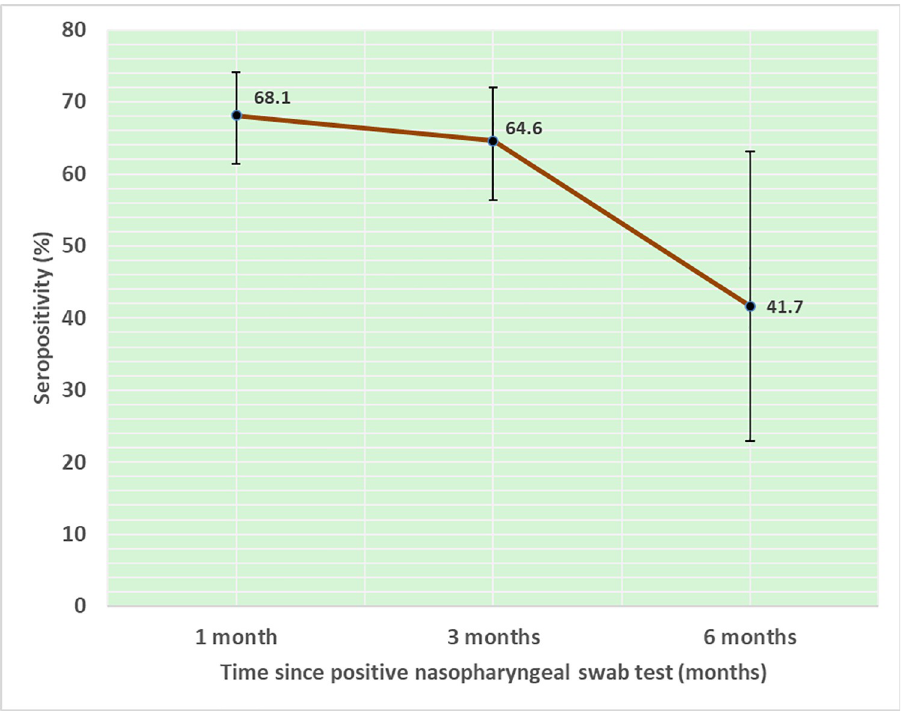
Fig 2. SARS-CoV-2 seropositivity with 95% CI and time (months) since nasopharyngeal swab